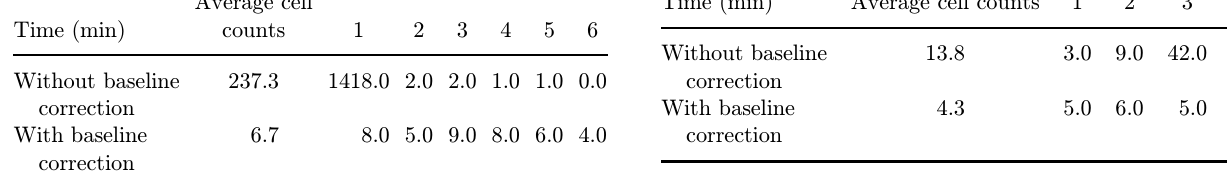
Table 3. Cell count results for a signal with abrupt baseline level change.